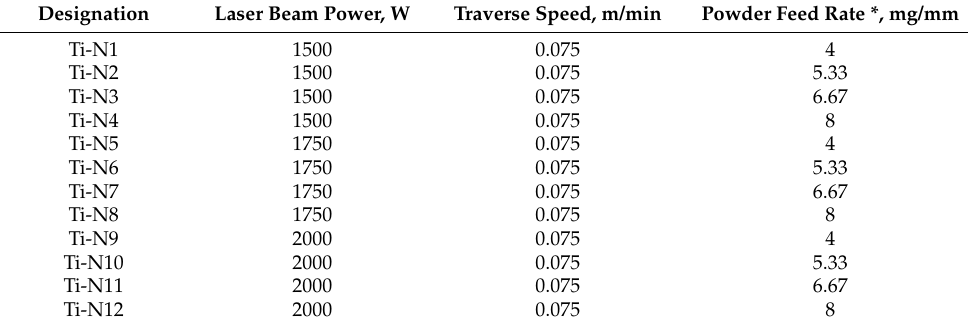
Table 3. The laser surface alloying process